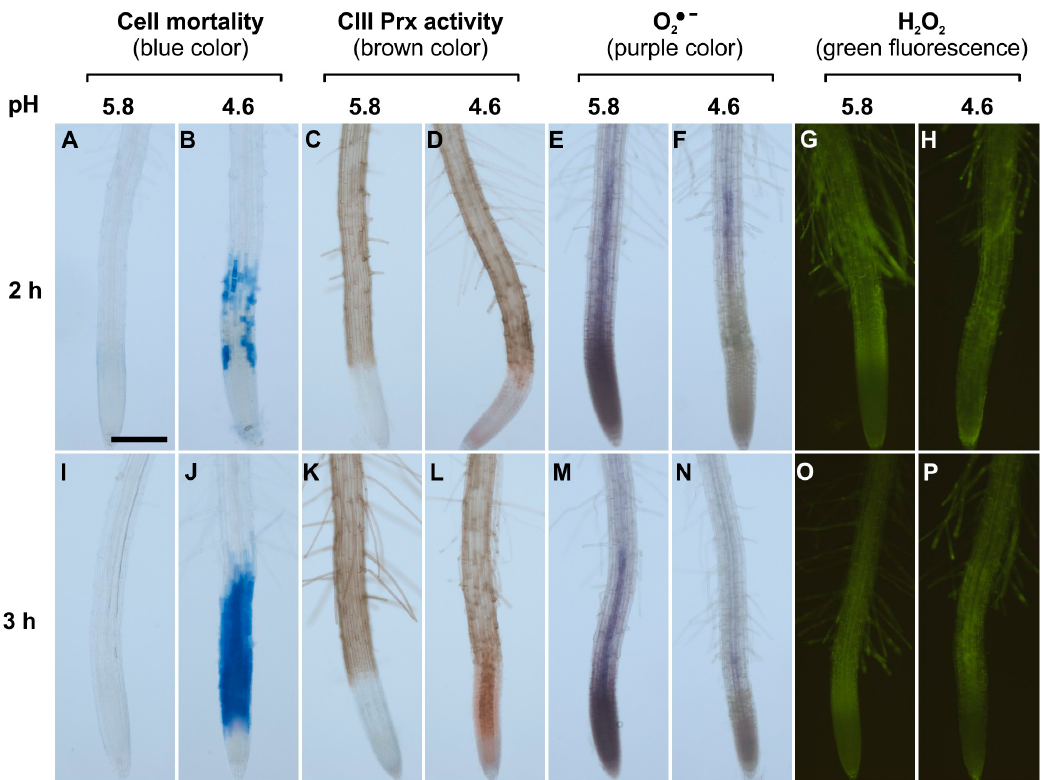
Figure 1. Spatio-temporal correlation between cell mortality, class III peroxidase (CIII Prx) activity, and ROS distribution in roots of Arabidopsis thaliana Col-0 upon low pH stress. Col-0 seedlings were treated at pH 5.8 ( A , C , E , G , I , K , M , O ) or 4.6 ( B , D , F , H , J , L , N , P ) for 2 h (upper panels) or 3 h (lower panels). Cell mortality was examined staining with Evans blue. Endogenous CIII Prx activity (total activity without distinction among the isoforms) was detected with a guaiacol / H 2 O 2 assay. The detection of O 2 •− was performed using nitro blue tetrazolium chloride (NBT). The detection of H 2 O 2 was realized using hydroxyphenyl fluorescein (HPF). Scale bar: 200 μ m. Three independent experiments ( n = 10) were performed with similar results and representative images are shown. Details of root zones are presented in Supplementary Materials Figure